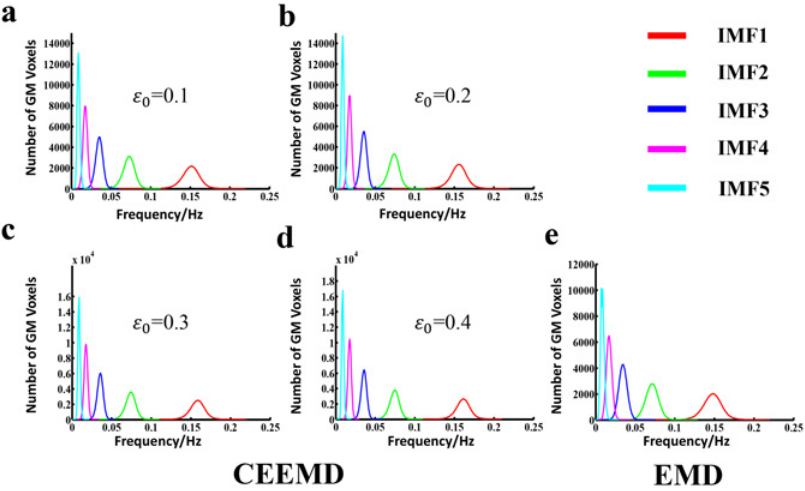
Fig 1. Histogram of frequency distribution using CEEMD and EMD, respectively. From Fig 1a to Fig 1e, each figure represents the HWF distribution histogram determined from gray matter voxels in whole brain across the entire group of subjects (n = 161), with an input noise level ε 0 of 0.1, 0.2, 0.3 and 0.4 using CEEMD as well as EMD respectively. The histograms of HWF of IMF1 to IMF5 were colored by red, green, blue, magenta and cyan respectively. The heights of the histograms represent the number of voxels whose HWF equals to the frequency on the horizontal axis.